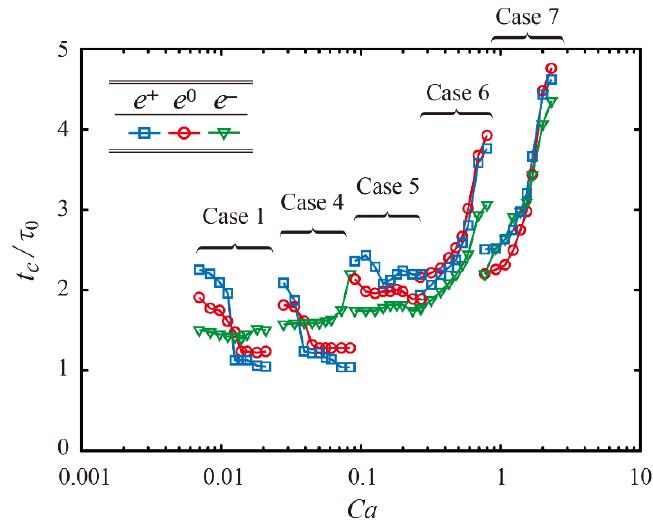
Figure 7. Normalized residence time as a function of Ca .